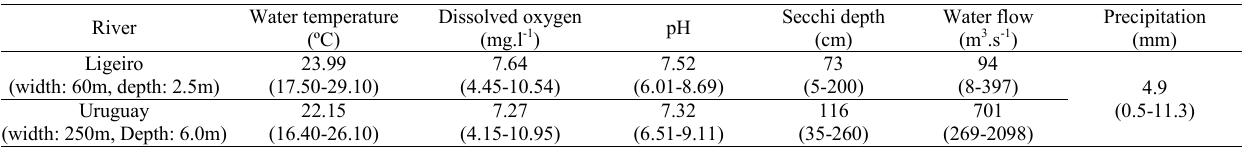
Table 2. Mean values (minimum-maximum) of environmental variables measured at the Ligeiro and Uruguay Rivers between October 2001 and February 2010.